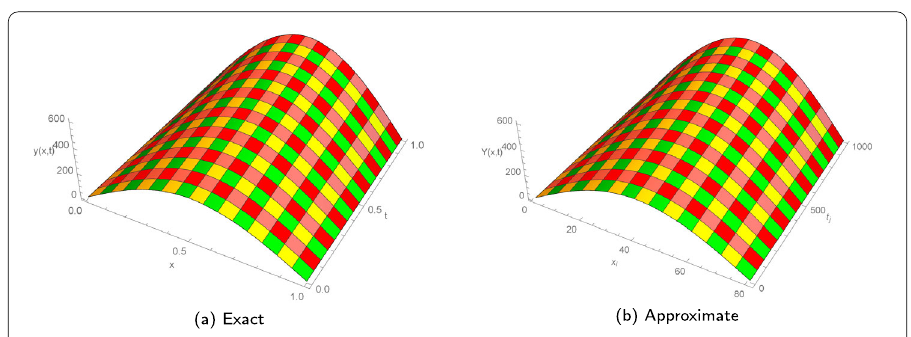
Figure 6 Exact and numerical solution for Problem 2 when N = 80, α = 1.25, (cid:2) t = 0.001